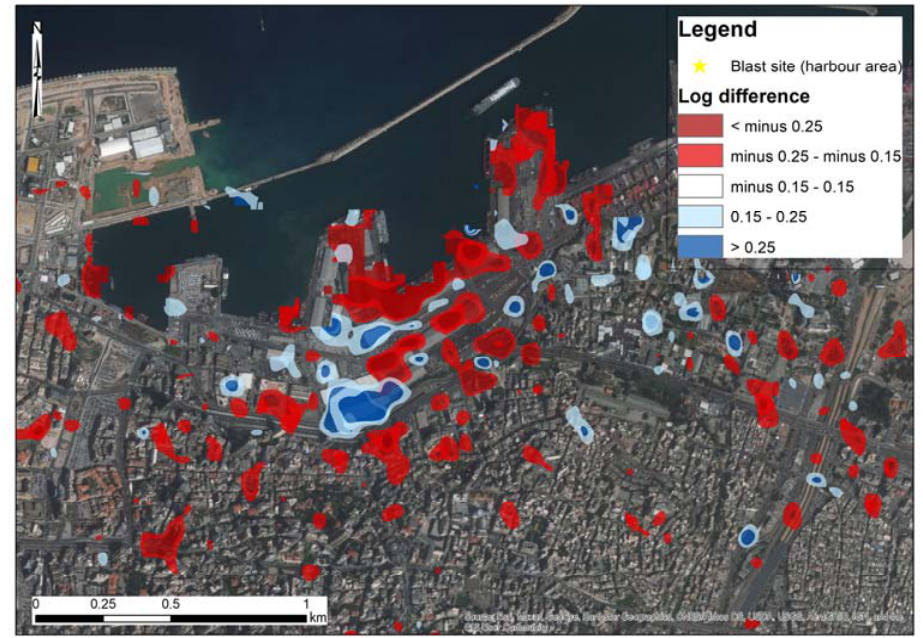
Figure 4. Change detection results—as in Figure 3, see before—for the area around the blast site near the harbor of Beirut (indicated with a white dashed line in Figure 3).